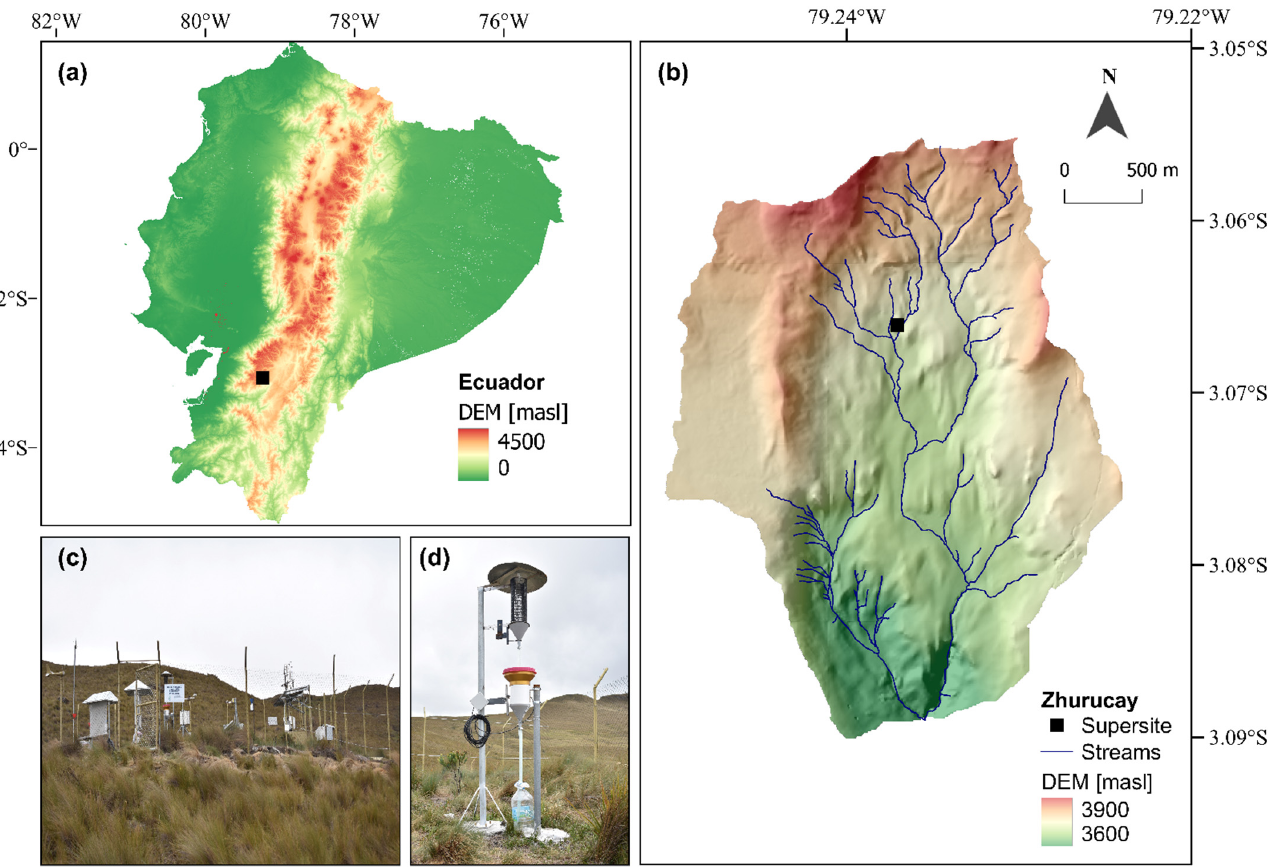
Figure 1. Zhurucay Ecohydrological Observatory: ( a ) location within Ecuador; ( b ) location of super- site within Observatory; ( c ) instrumented super-site hillslope; ( d ) Juvik fog gauge.